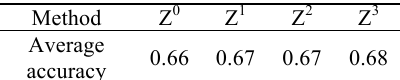
Table 7. Classification accuracies for SVM-MLP method, 5- best features selected using SFS.